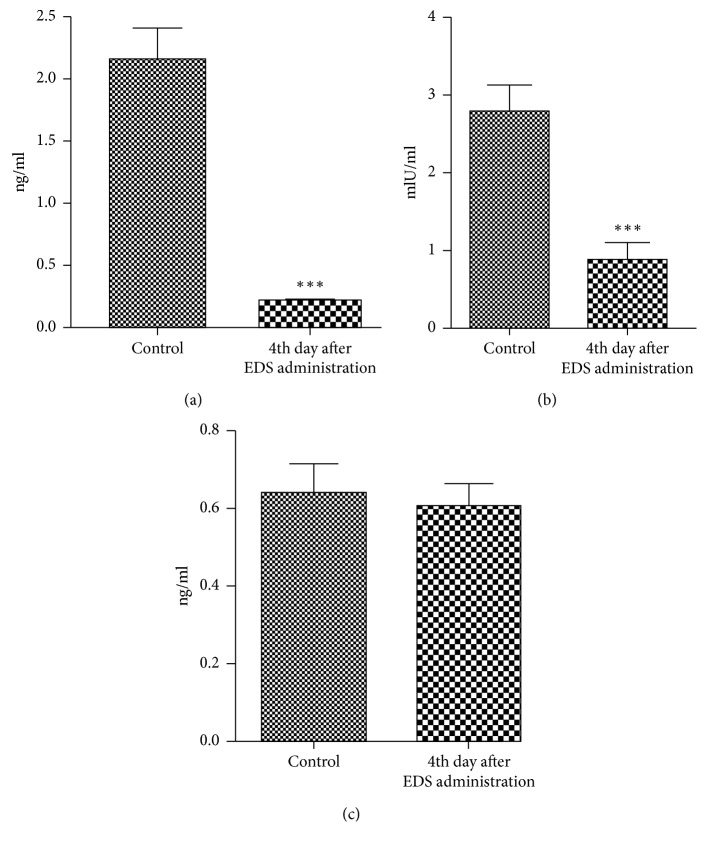
Statistical evaluation of serum testosterone (a), LH (b), and ucOC (c) levels of subjects sacrificed on the 4th day after EDS administration. ∗∗∗p < 0.0001; ∗∗p < 0.001; ∗p < 0.01.